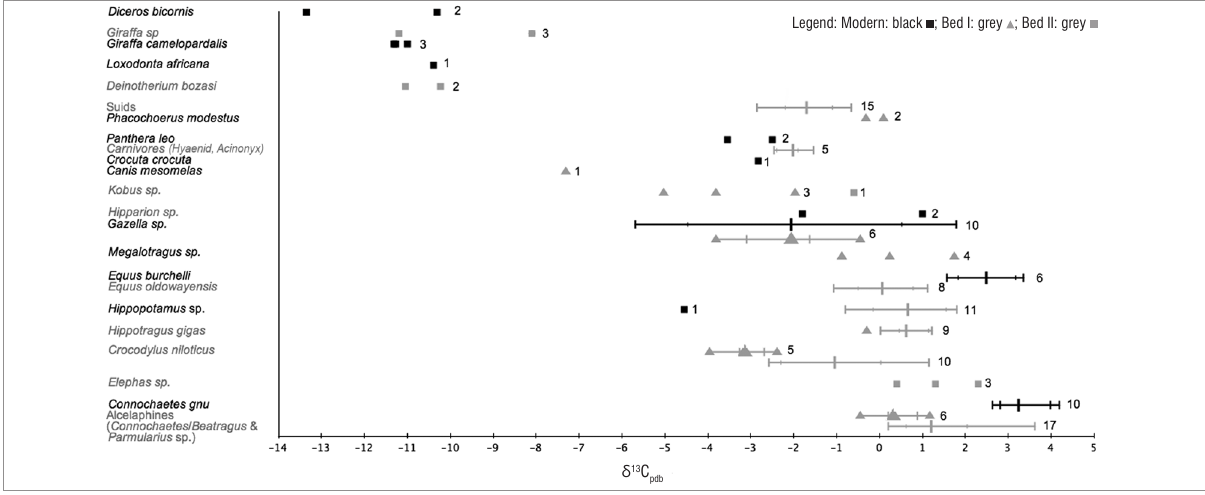
+1.5‰ has been added to the modern values to correct for the industrial effect. Figure 4: δ 13 C from tooth enamel of modern fauna from the Serengeti (in black) and from fossil fauna from Olduvai Beds I and II at ca 1.8 Ma (in